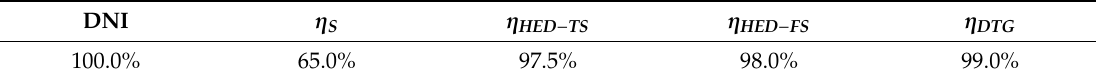
Figure 4. Functional unit for power block and net electric energy output models [14]. 2.4.2. Implementation of the Model into Real PT Plant The solution of the mathematical optimization problem was formulated by linear programming using the MATLAB © [43] “linprog” solver. Hourly updates of corrections are introduced in the model matrix of vectors due to deviations in final solar radiation, final prices of market, energy accounting in the storage system, and electric power finally produced. The proposed model uses parameters of positive real values formed by vectors of 8760 elements of real numbers. The optimization model used variables are solar resource, 𝑅 𝐷𝑁𝐼 , solar multiple, 𝐹 𝑆 , TES, 𝑁 𝐻 , thermal energy from storage, 𝑄 𝐹𝑆 ,thermal energy to storage, 𝑄 𝑇𝑆 , fadeout, 𝑄 𝐻𝐶𝐸−𝐹 , and price of electricity in DEM, Π 𝐷𝑀 , formed by vectors of 8760 elements of real numbers [26]. The results of production were obtained over four vectors of 8760 values, the electricity power generated, 𝑃 𝐸_𝑗 , using a predictive model, the electricity price on REM, Π 𝑅𝑀_𝑗 , and DEM, [ Π 𝐻𝑀𝑃_𝑗 ; Π 𝐿𝑀𝑃_𝑗 ] through historical values. Π 𝐻𝑀𝑃_𝑗 and Π 𝐿𝑀𝑃_𝑗 correspond to high/low price of electricity into DEM. 2.4.2.1. PT Plant Model Calibration Model calibration by using data from a currently operated PT plant validates the used tools. In the calibration process, validation of the model is made by comparison of the behavior of two of its main parameters in both model data results and those from the real system of the plant. They were the mass flow of synthetic oil at the exit of the pressure group in the solar field, and the fluid temperature at the same point. The use of these values is determined by their significance in plant operation. For this calibration, real physical parameters from the “La Africana Energía” 50 MW e PT solar-thermal power plant located in Posadas (Spain) 37°45'N 5° 3'W were used. After completing